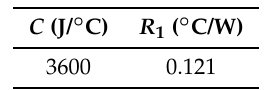
Table 1. Building model parameters